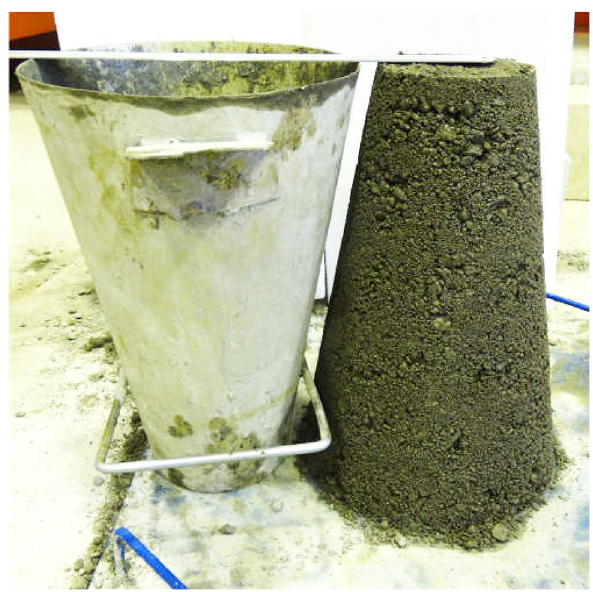
Fig. 7 The slump test of CSG mixture with 12.5% cement content and in the fresh state